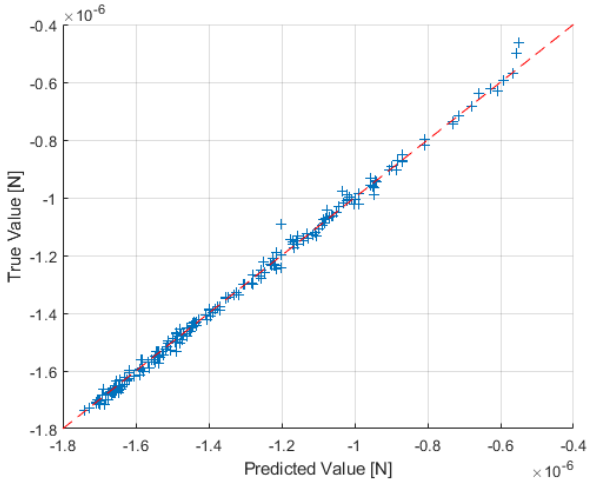
Figure 8. True values versus predicted values of the maximum torque